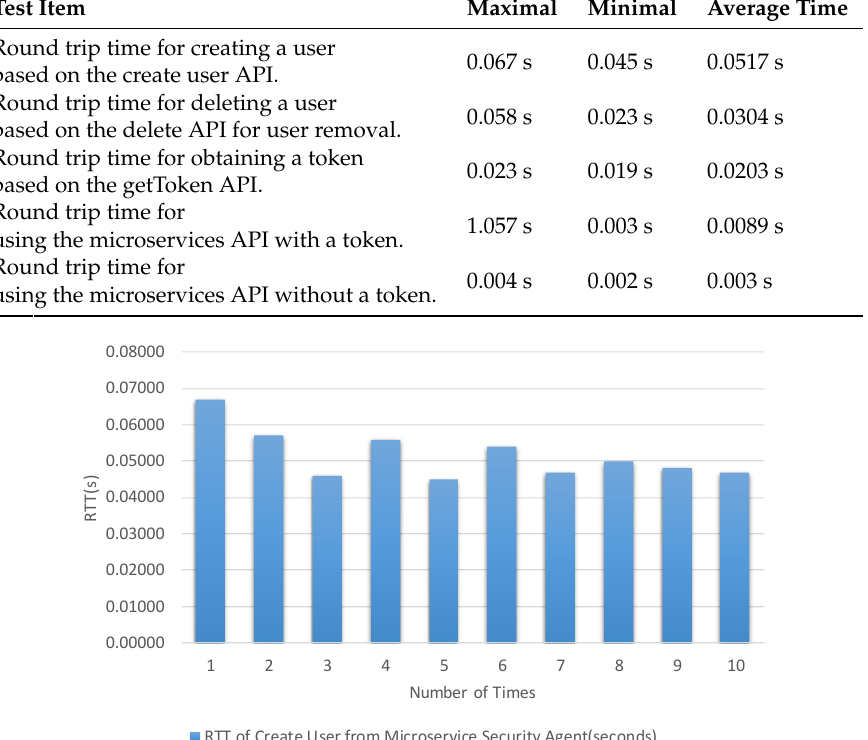
Figure 13. Round trip time for creating a user based on the create user API.